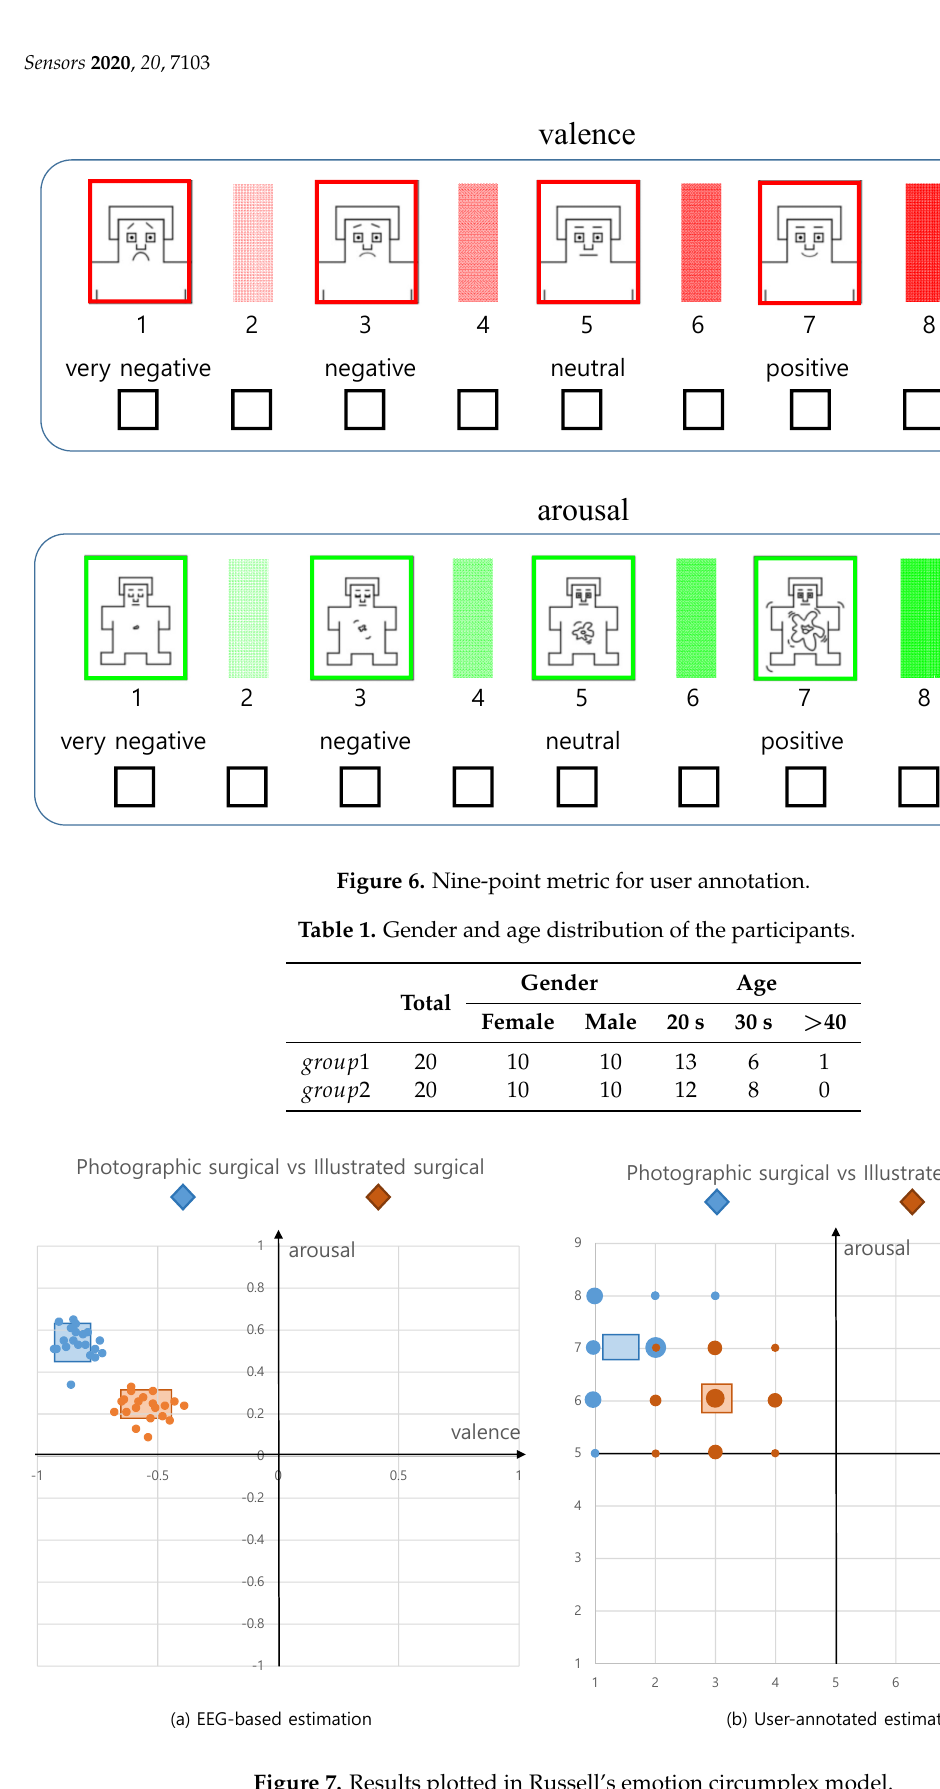
Figure 7. Results plotted in Russell’s emotion circumplex